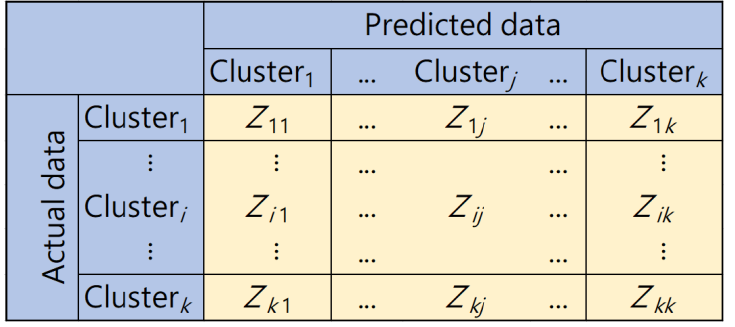
Figure 4. Confusion matrix table.